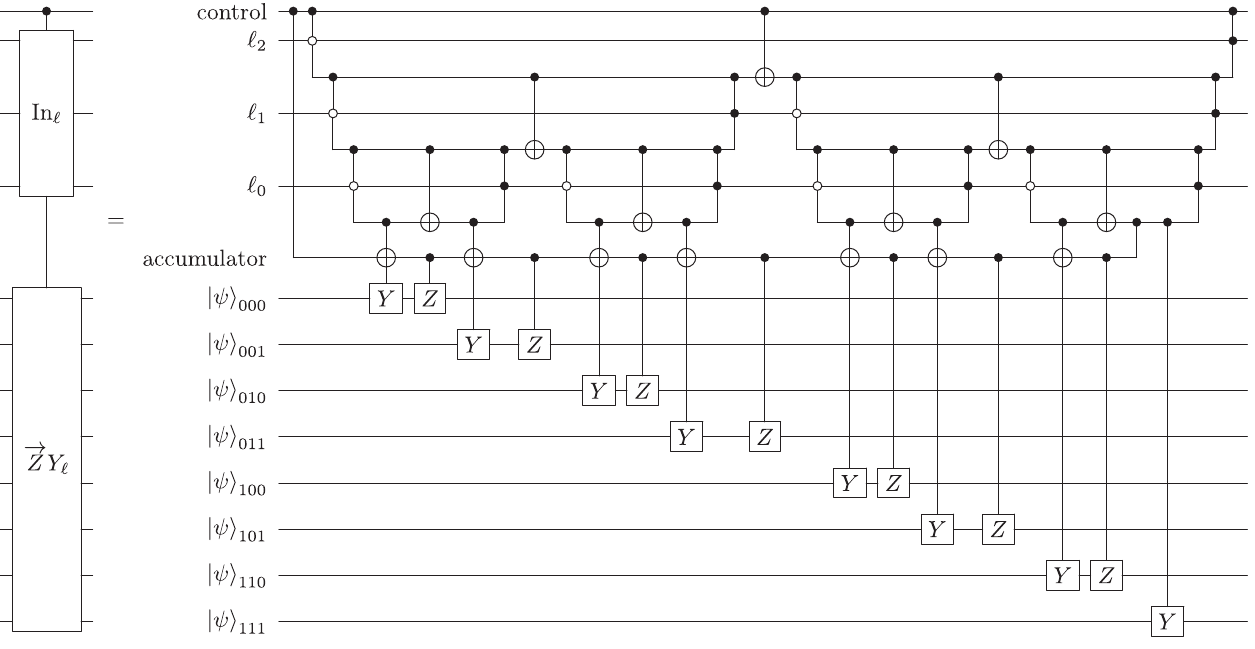
FIG. 9. Application of a selected Majorana fermion operator, j l ij ψ i ↦ j l i Y l · Z l − 1 (cid:4) (cid:4) (cid:4) Z 0 j ψ i as described in Eq. (30). This application is accomplished by performing a ranged operation (as shown in Fig. 8) and an indexed operation (similar to what is shown in Fig. 7) with a single pass through the selection register j l i . It has a T count of 4 L − 4 , where L is the number of integer values that can be held by the selection register j l i